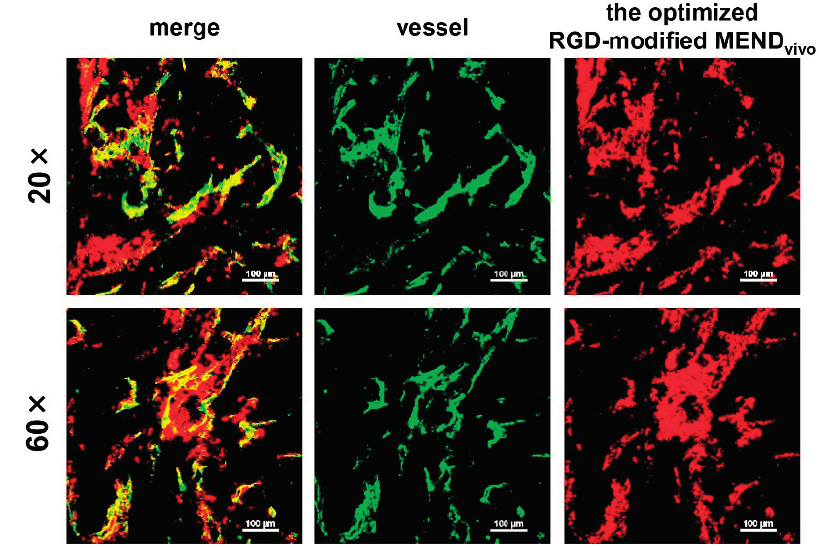
Figure 5. Intratumoral localization of the optimized RGD-modified MEND vivo . The MEND was injected into OS-RC-2-bearing mice, and, 24 h after the injection, tumor tissue was excised. The collected tumor tissue was stained with FITC-labeled GSIB4, and observed with CLSM with a 20× objective lens (upper panels) and 60× objective lens (lower panels). Green and red dots represent the vessel and the MEND,